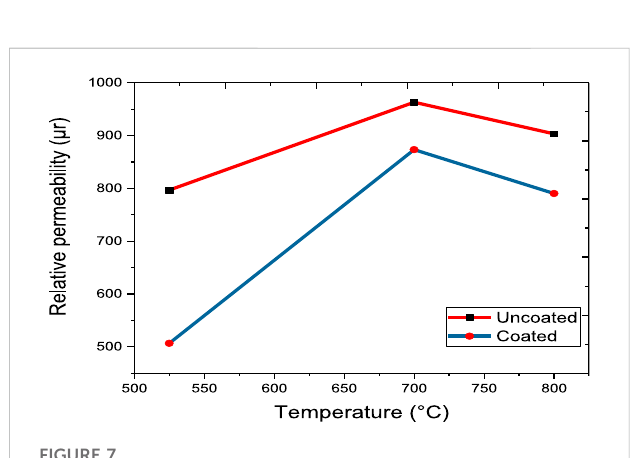
FIGURE 7 Permeability at 400 Hz, 1.5 T for coated and uncoated samples at different temperature.